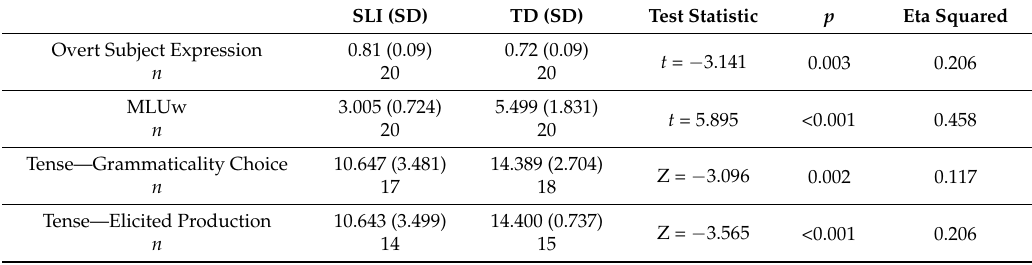
Table 5. Mean rates of null subject use, mean length of utterance in words (MLUw), grammaticality choice measures of tense and elicited oroduction measures of tense across SLI and TD age control groups.